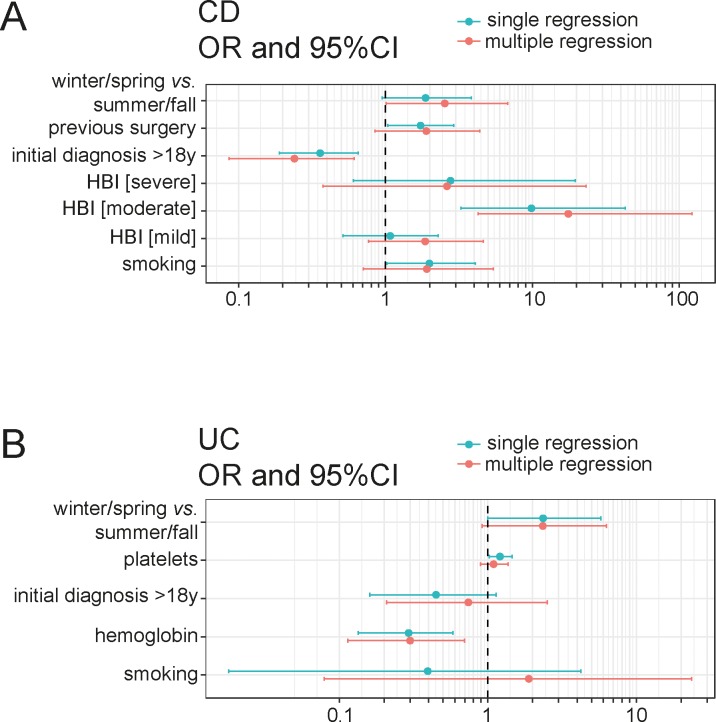
Univariable and multiple regression analyses to determine independent risk factors for vitamin D deficiency in patients with CD (A) and UC (B). Models of multiple regression including the indicated clinical factors were used and are indicated as Forest plots.